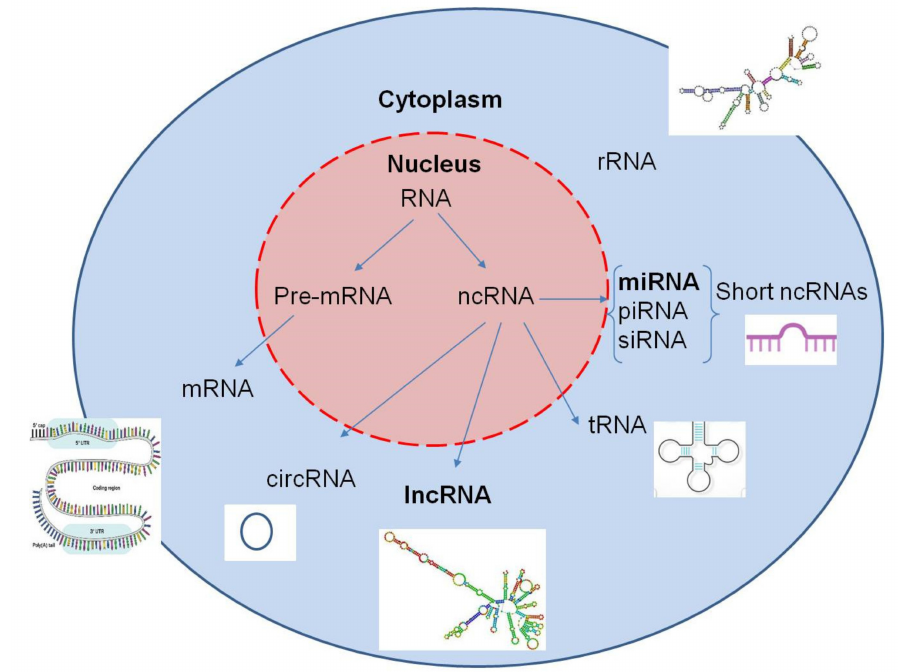
Figure 4. Coding and noncoding RNAs: precursor messenger RNA (pre-mRNA) generates the protein-coding messenger RNA (mRNA). Noncoding RNAs (ncRNAs) include ribosomal RNA (rRNA) and other varieties that are categorized into short and long